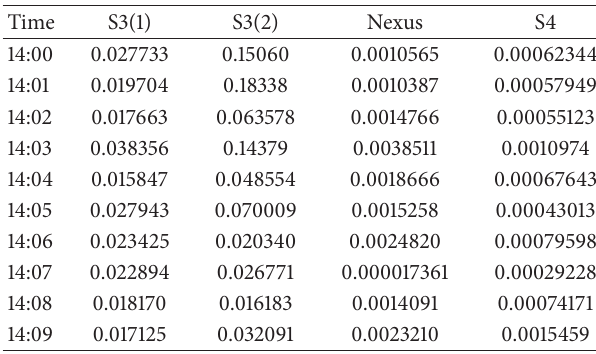
Table 8: S3(1) calculation result of 𝑊(𝑡) and 𝑥 𝑖 (𝑡 + 1) . Time Vaisala